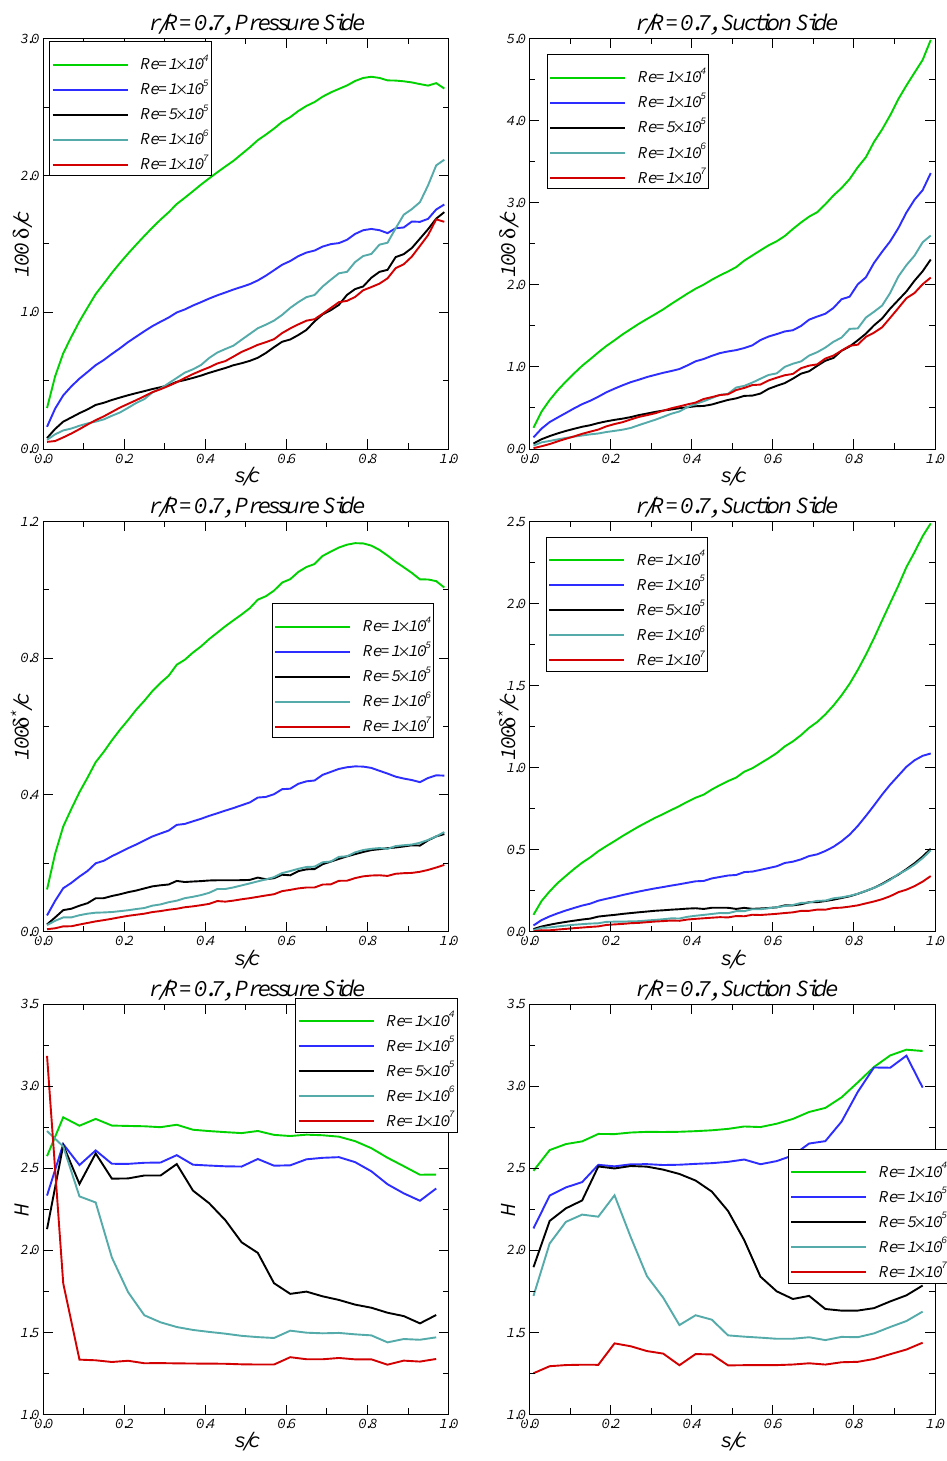
Figure 22. Boundary-layer thickness δ ( top ), displacement thickness δ ∗ ( middle ), and shape factor H ( bottom ) at r / R = 0.7 using the γ − ˜Re θ